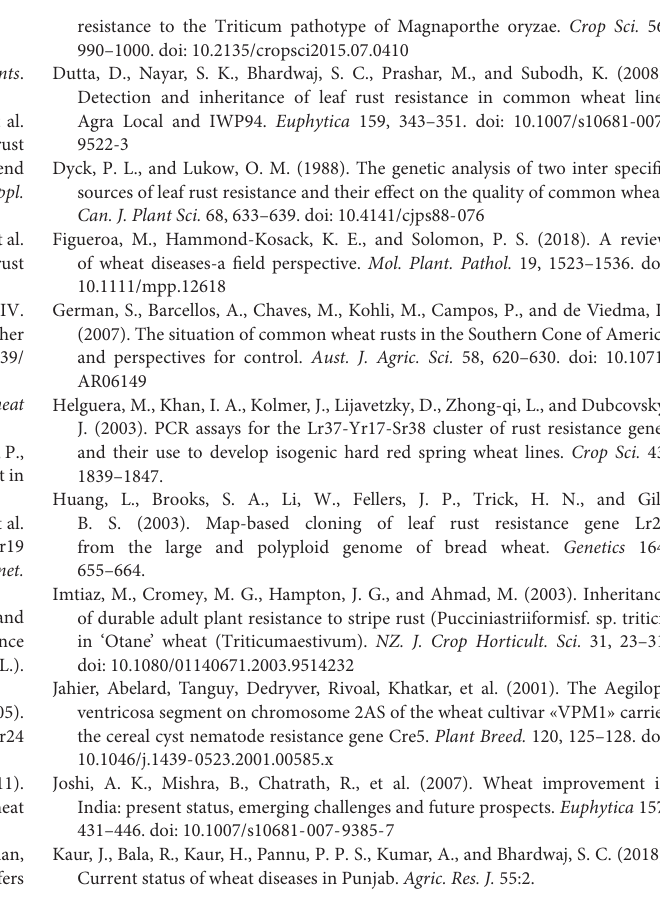
Supplementary Figure 1 | Flow diagram showing the wheat varietal release procedure in India. Supplementary Figure 2 | Schematic representation depicting the summary of attempts involving the mobilization of stripe and leaf rust resistance in the course of improving PBW343 and the fate of this developed